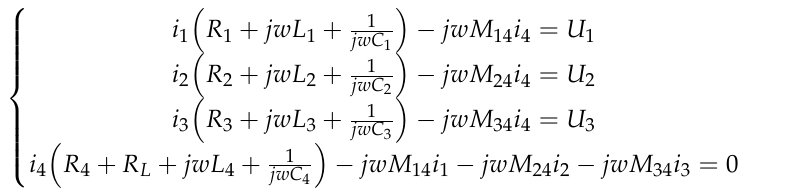
Figure 3. The equivalent circuit modelling of the 3D WPT system. The electric currents flowing in the sending coils T x , T y , and T z are replaced by i 1 , i 2 , and i 3 , respectively, throughout the entire rest of the article. The system’s electric parameters are related mathematically using Equation